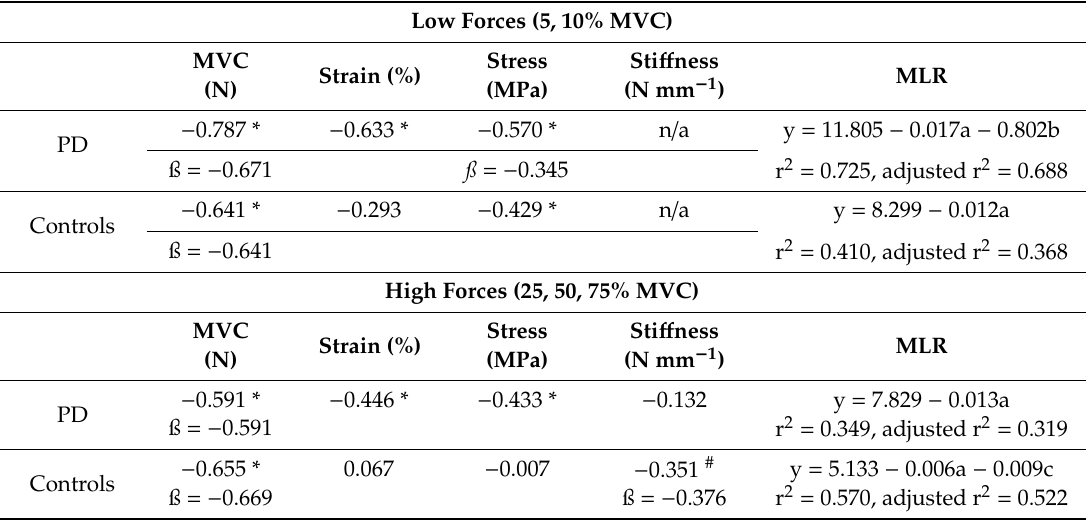
Table 3. Multiple linear forward regressions of MVC, tendon mechanics and CV of force at low (5, 10% MVC) and high (25, 50, 75% MVC) force